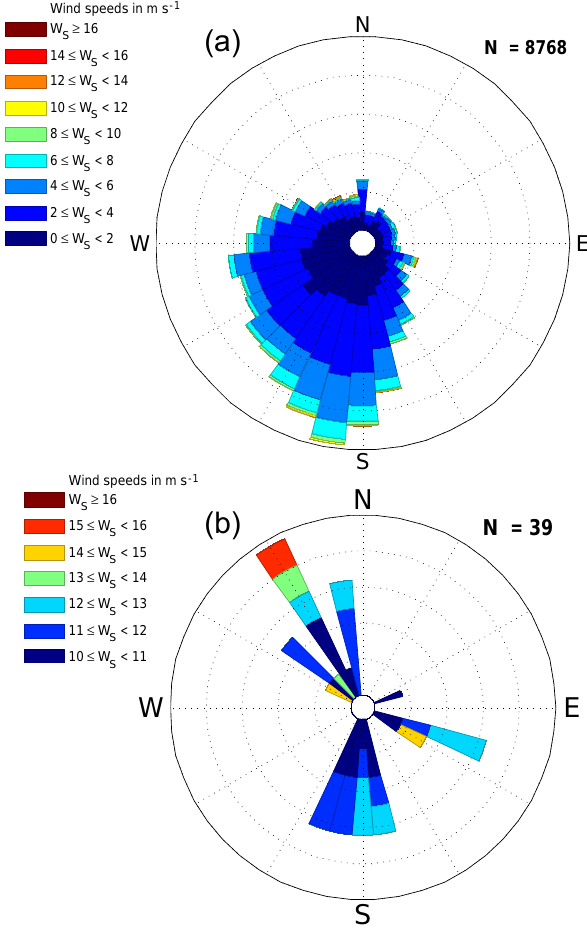
Figure 3. (a) Observed wind speed W s and direction at Dome C AWS. (b) Observed wind speed W s and direction for cases with wind speeds larger than 10ms − 1